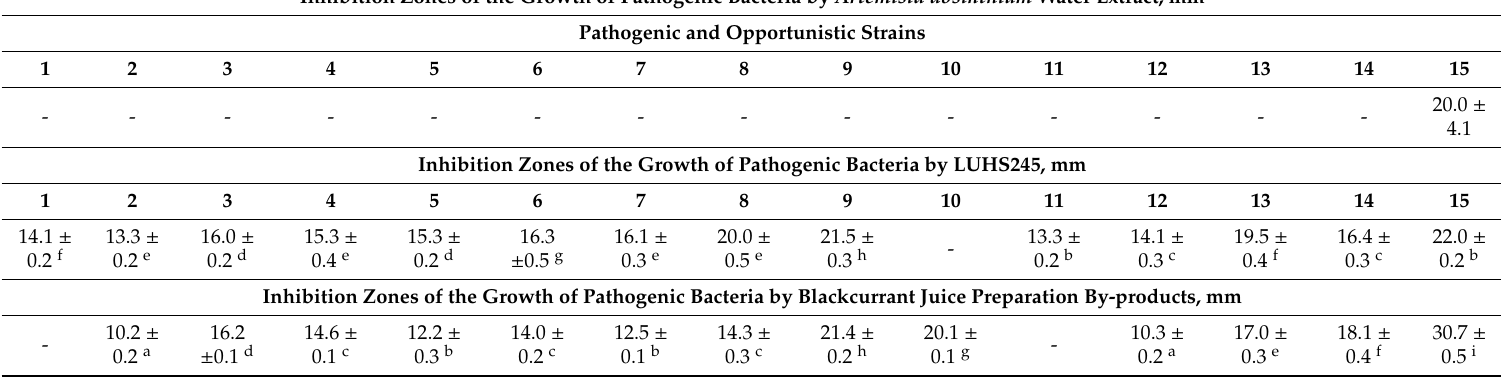
Table 1. Inhibition of the growth of pathogenic bacteria by Artemisia absinthium water extract, L. uvarum LUHS245 cultivated in a whey substrate, and blackcurrant juice preparation by-products.